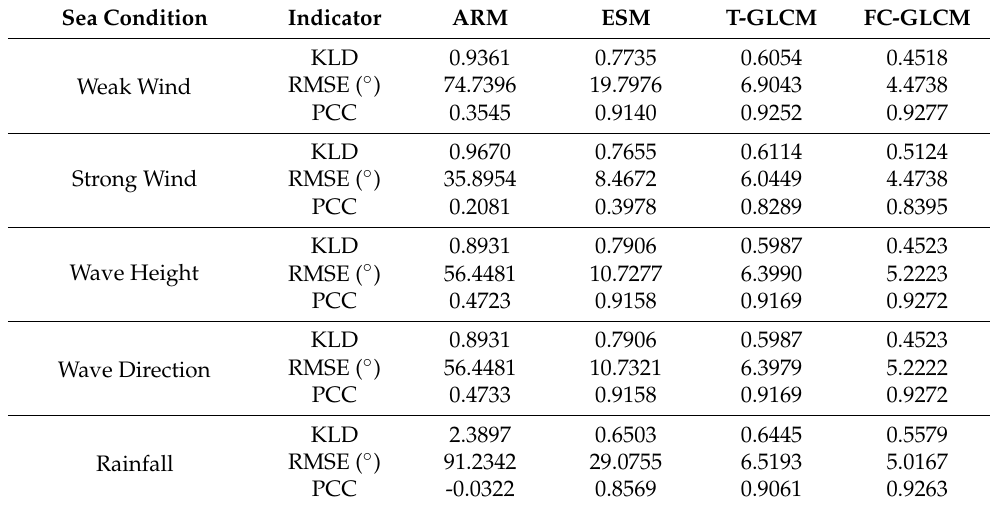
Table 6. Comparison between FC-GLCM algorithm and classic method under different sea